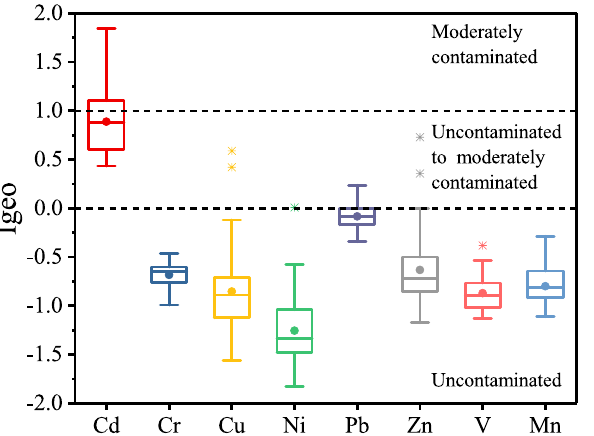
Figure 2. Igeo values for heavy metals in the research area.